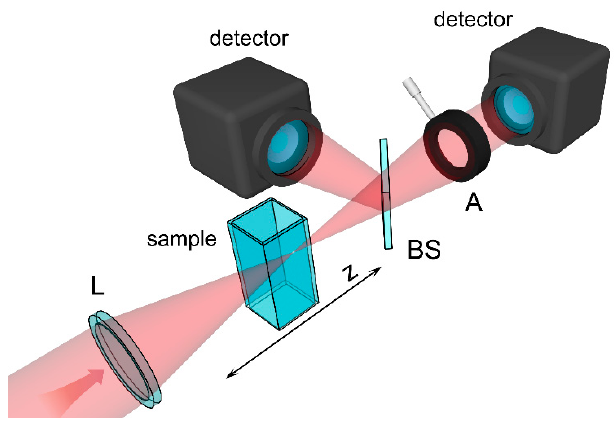
Figure 2. Z-scan schematic. Focusing lens (L), beam splitter (BS), aperture (A).